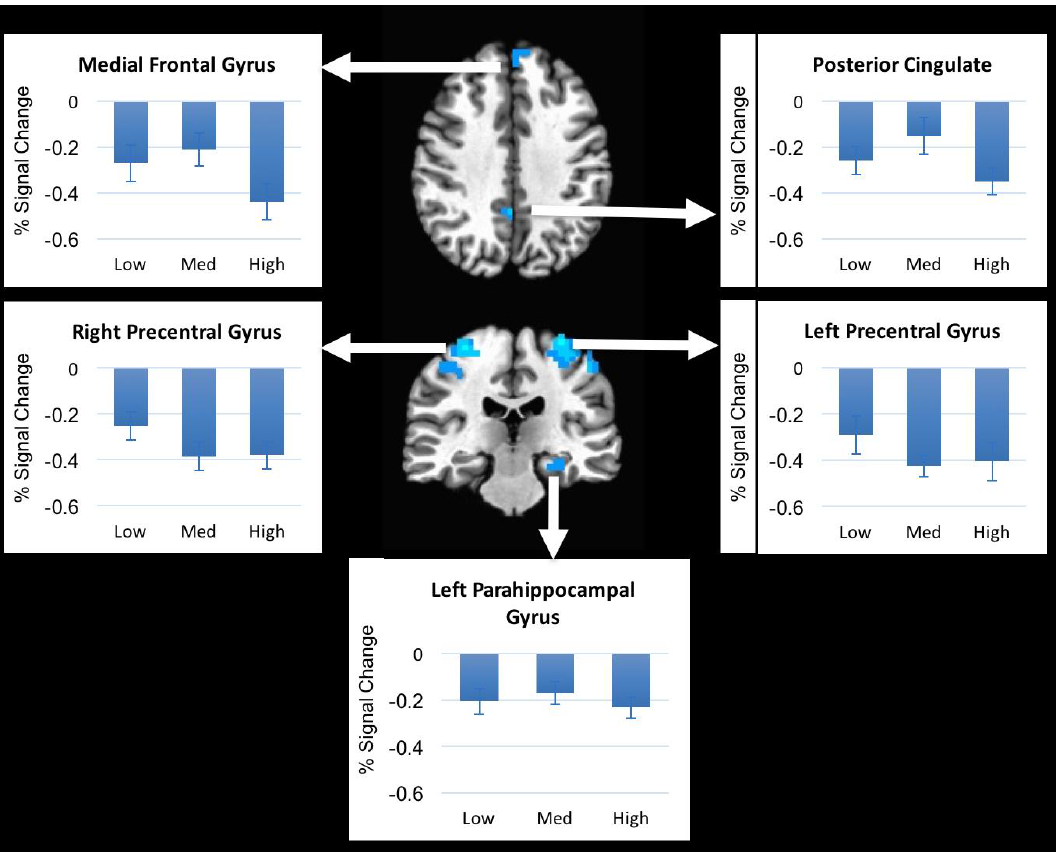
Figure 3. Decreased brain activation in response to mechanical pressure when compared to rest.